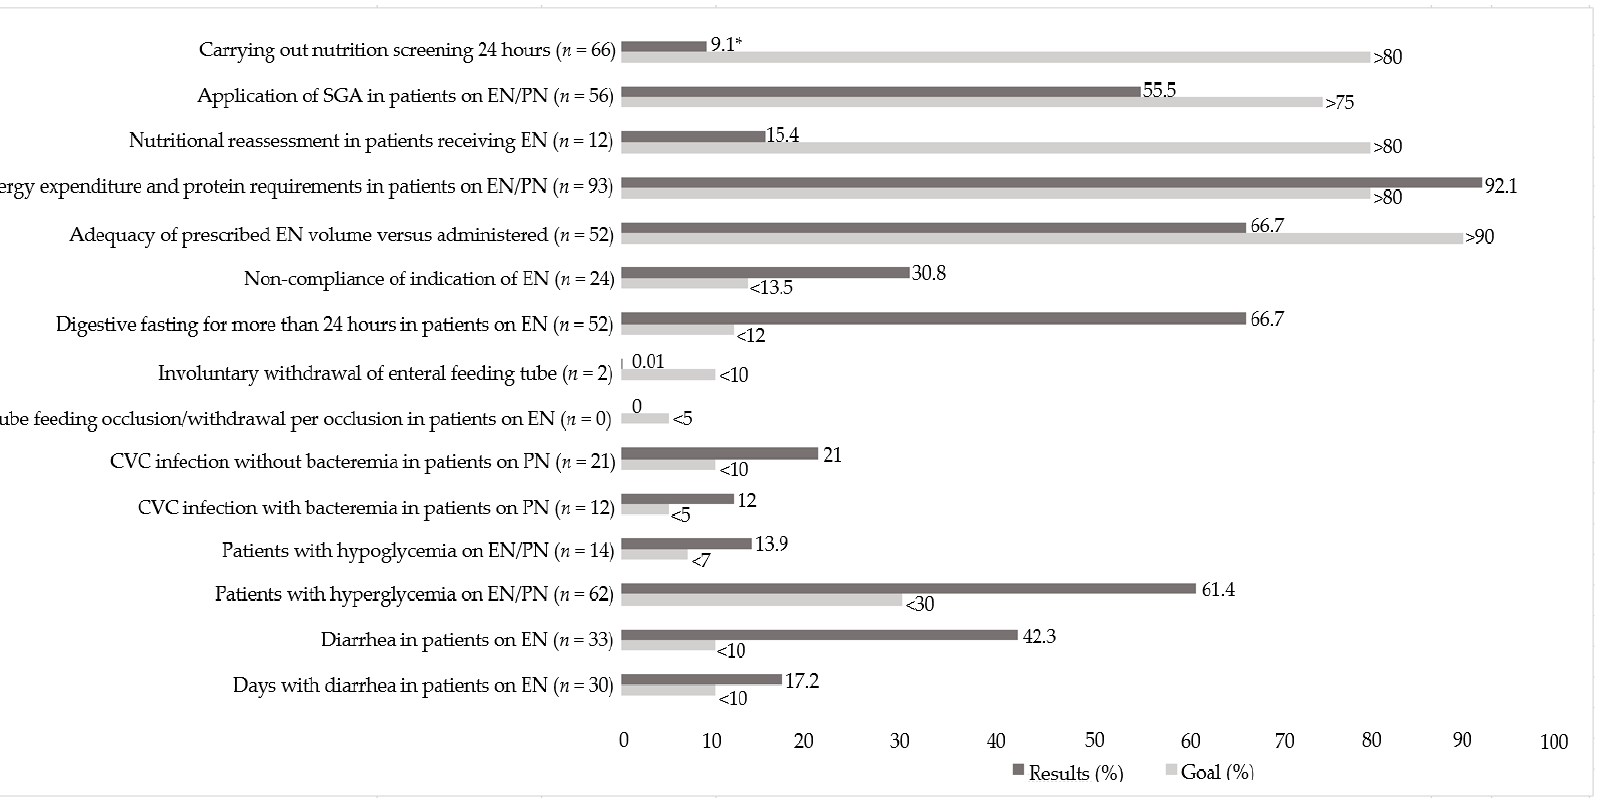
Figure 3. Quality indicators in enteral and parenteral nutrition therapy and goals (%). (* N = 727; N = 101; ENT = 78; PNT = 23) Abbreviation: SGA, subjective global assessment; EN, enteral nutrition; PN, parenteral nutrition; ENT, enteral nutritional therapy; parenteral nutritional therapy, PNT; CVC, central venous catheter. Light bars indicate the recommended goals and the dark bars indicate the results obtained in the study.